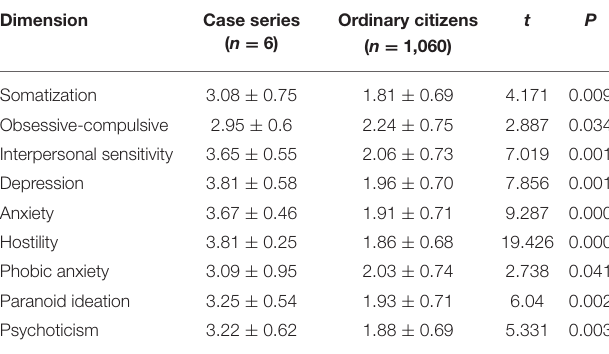
TABLE 3 | Psychological status of the case series according to SCL-90, compared to ordinary citizens during COVID-19.